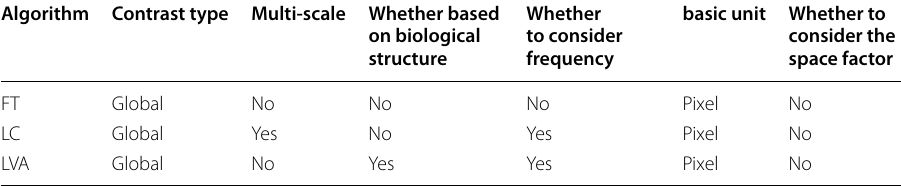
Table 1 Description of the respective characteristics of the three detection algorithms Algorithm Contrast type Multi‑scale Whether based on